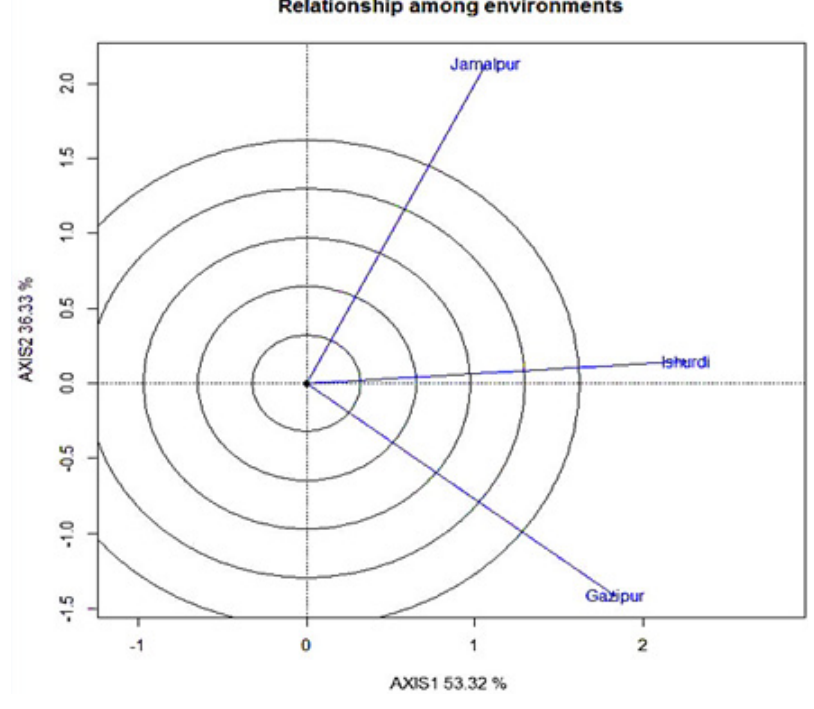
Figure 4: Vector view of GGE biplot analysis for relationship among three